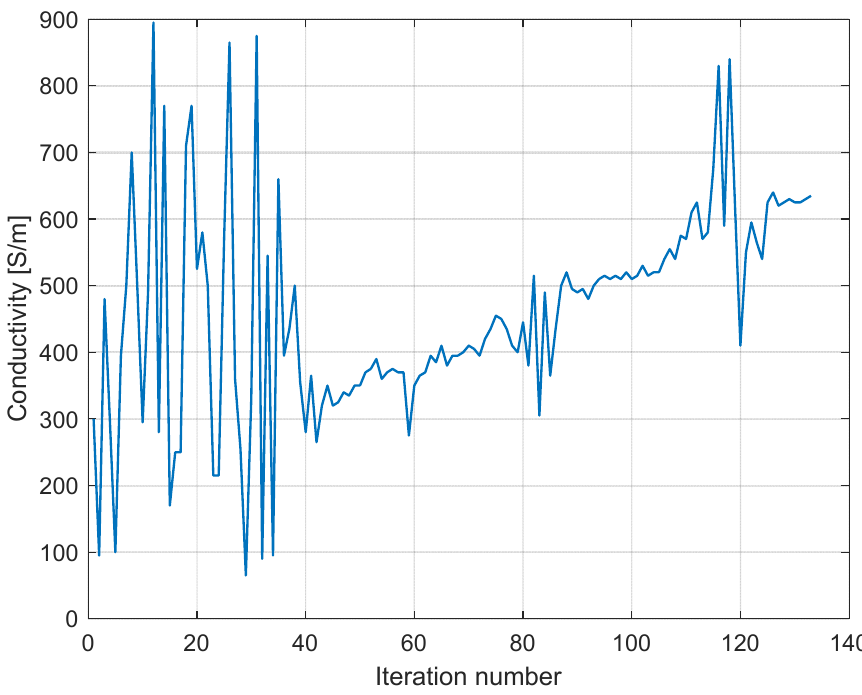
Figure 10. History of the optimization process. The changes in material conductivity over iterations.